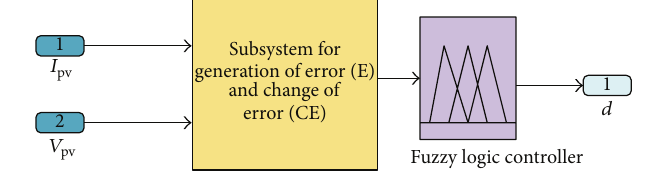
Figure 11: The external block view of the fuzzy logic algorithm.